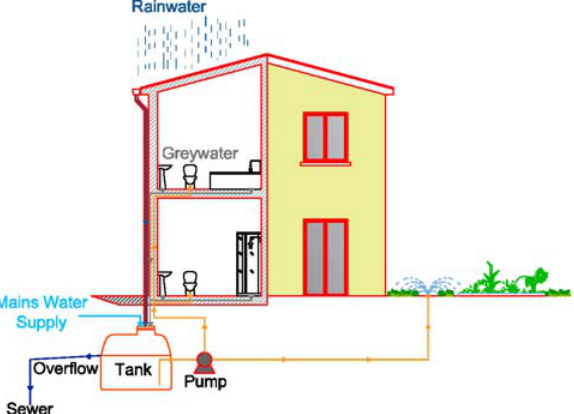
Figure 1. Schematic representation of a rainwater and greywater tank